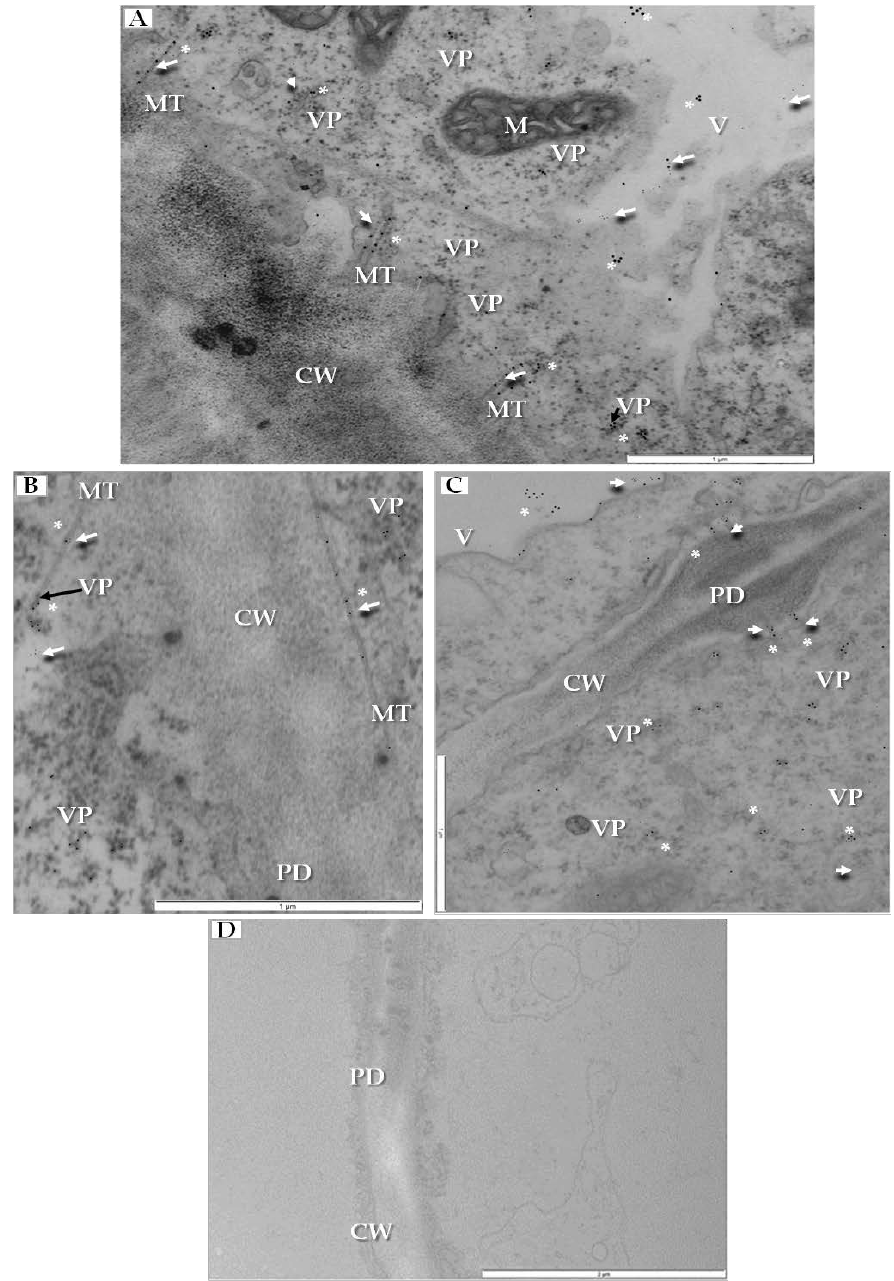
Figure 9. Double-immunogold localization of PDV movement protein (MP) and coat protein (CP) in infected cucumber leaf tissues (14 dpi). ( A ) MP epitopes (white arrow) and CP epitopes (*) colocalized in tubular structures in plasmodesmata, cytoplasm and vacuole. CP epitopes (*) on the surface of viral particles. Labeled viral particles in cytoplasm (VP, black arrow), Bar 1 µm; ( B ) Viral particles (VP, black arrow) in tubular structure. Co-localization of MP epitopes (white arrow) and CP epitopes (*) are visible, Bar 1 µm; ( C ) Two types of gold particles (* and white arrow) from CP and MP co-localized in cytoplasm and in plasmodesma, Bar 1 µm; ( D ) Fragment of parenchyma cell from mock-inoculated cucumber without MP and CP epitopes, Bar 1 µm. Abbreviations: CW—cell wall, PD—plasmodesmata, M—mitochondrion, V—vacuole, MT—movement protein induced tubular structures, VP—viral particles.